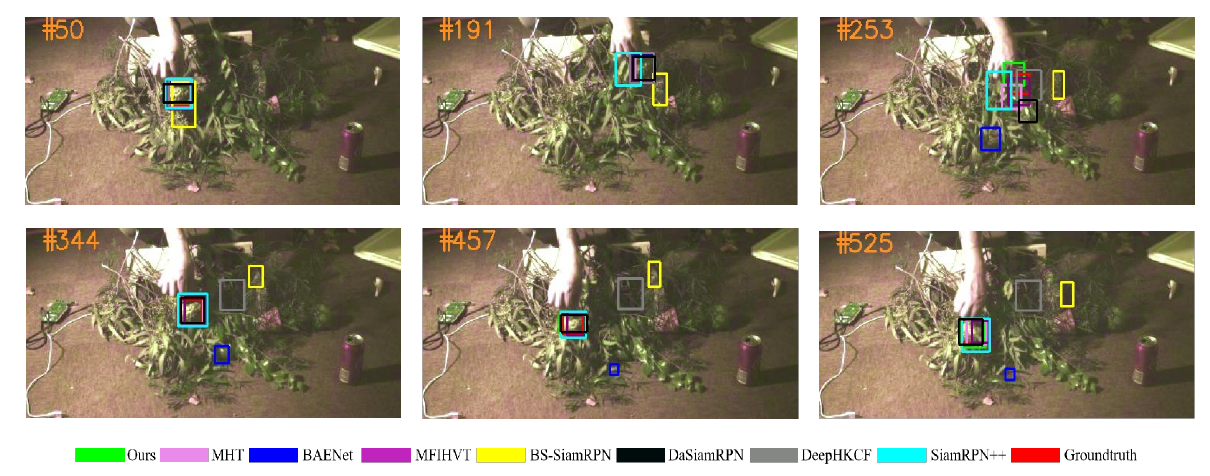
Figure 10. Qualitative results on the fruit sequence.